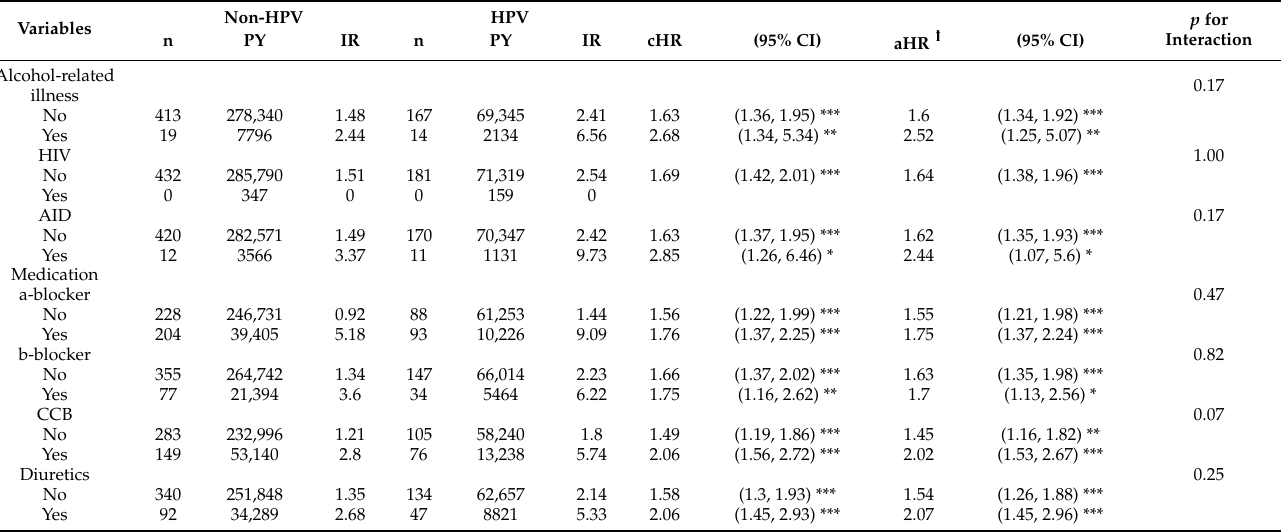
Table 3. The association of explanatory variables and the risk of erectile dysfunction.